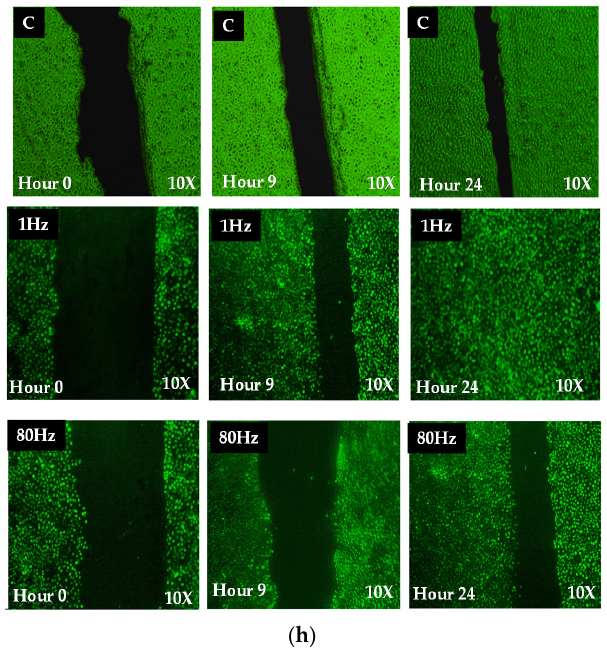
Figure 4. ( a ) curve of the cytocompatibility assay for eight experiments repetition ( n = 28 control samples (C) and n = 25 control material samples (CM)). No significance ( p < 0.05) was found. ( b ) curves for experiment 80 Hz applied. ( n = 9 control samples (C), n = 9 control static samples (CM) and n = 8 dynamic samples at 80 Hz frequency) ** Significance ( p < 0.05) in days 3 and 6. ( c ) curves for two repetitions of experiment 1 Hz applied ( n = 12 control samples (C), n = 12 control static samples (CM) and n = 12 dynamic samples at 1 Hz frequency) *** Significance ( p < 0.05) in days 6 and 8; ( d ) area decrease in scratch assay due to migration process in control devices (C). Value in the curve at 30 h represents that the healing closed completely at the observation, but not the closing time.; ( e ) area